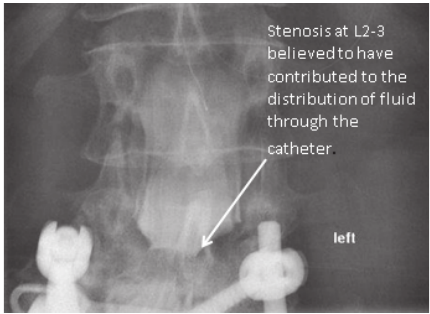
Figure 2: Severe central canal stenosis at L2-3 which is believed to have contributed to the distribution of fluid injected through the catheter.